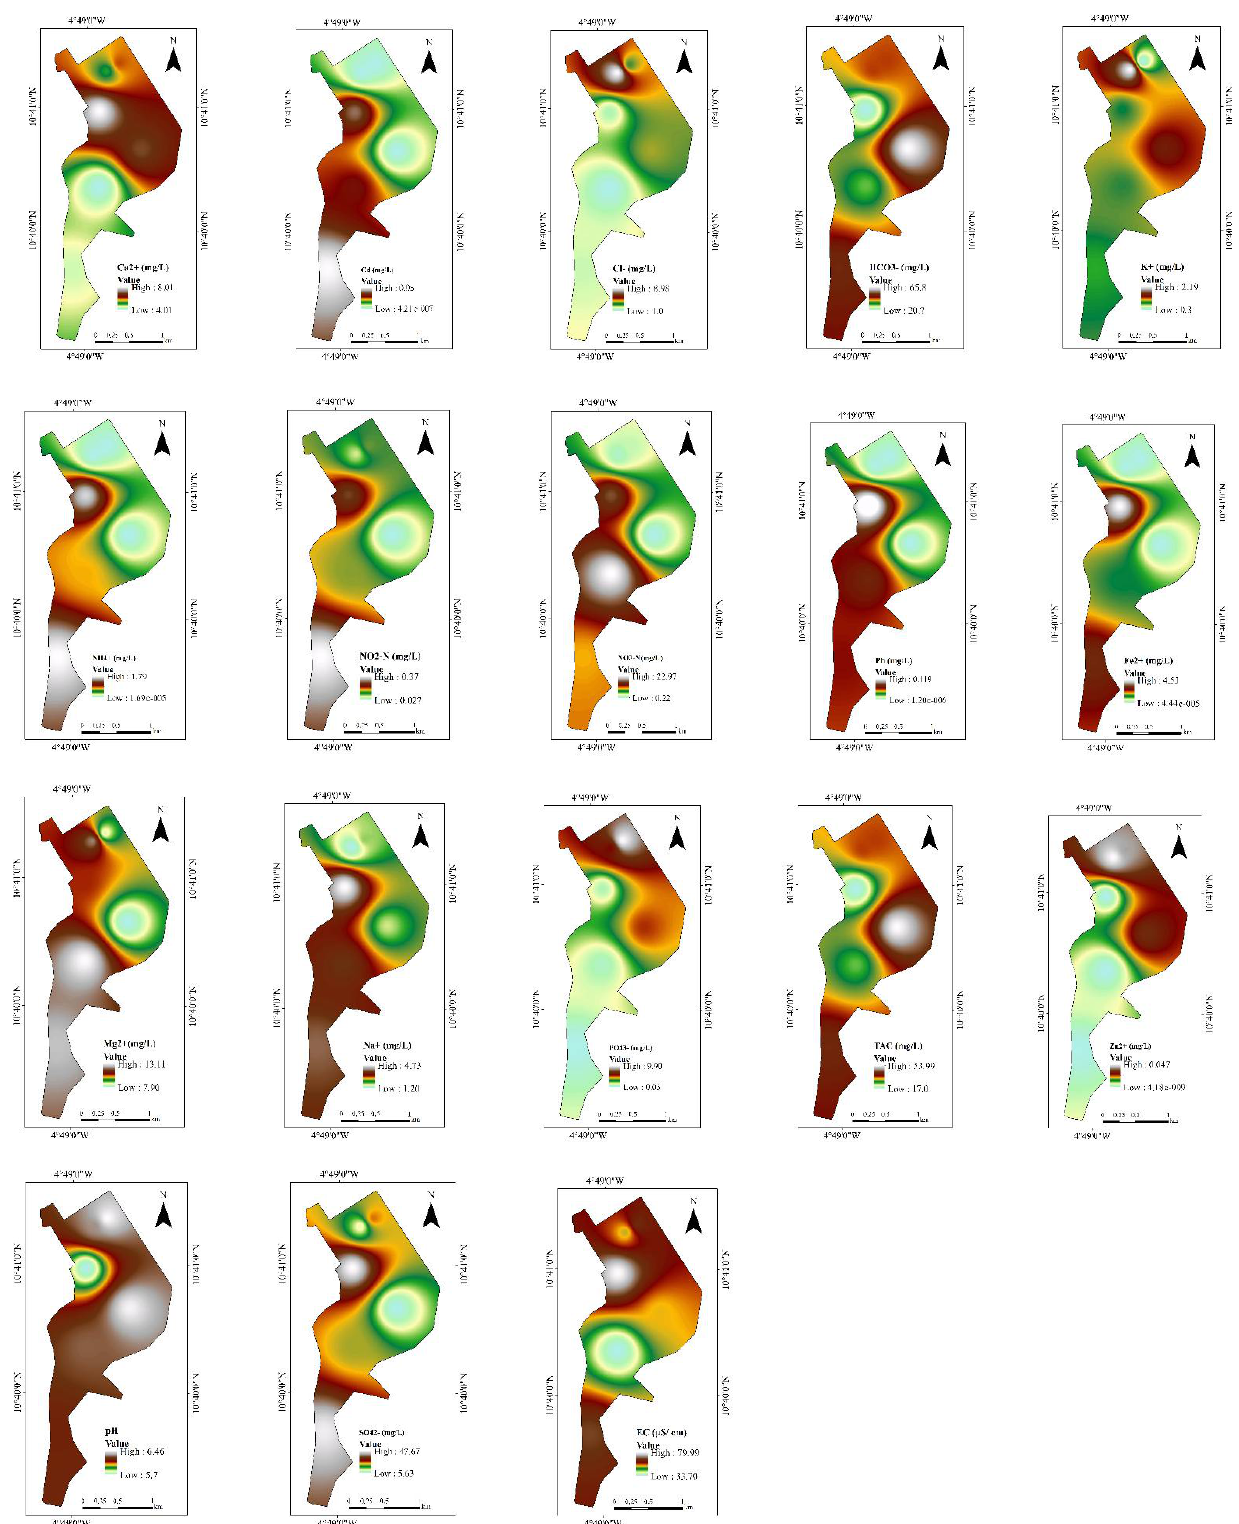
Figure 2. Spatial distribution of physicochemical parameters. The order of the major anions is HCO 3 − > SO 42 − > NO 3 − > PO 43 − > Cl − with, respectively, mean concentration values of 42.7 ± 15.78 mg/L, 26.34 ± 17.66 mg/L, 9.01 ± 9.51 mg/L, 3.68 ± 3.94 mg/L, and 3.45 ± 2.95